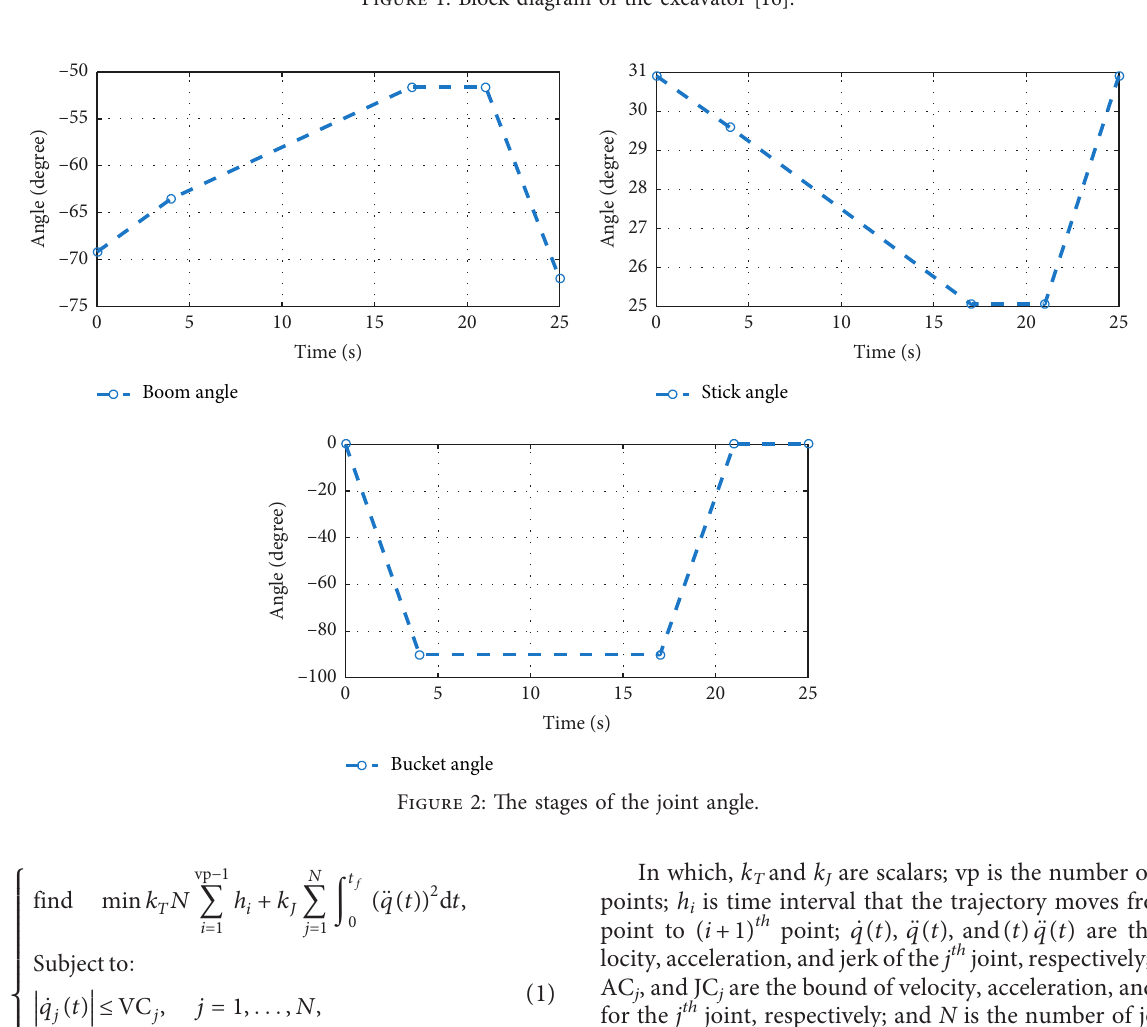
Figure 1: Block diagram of the excavator [16].